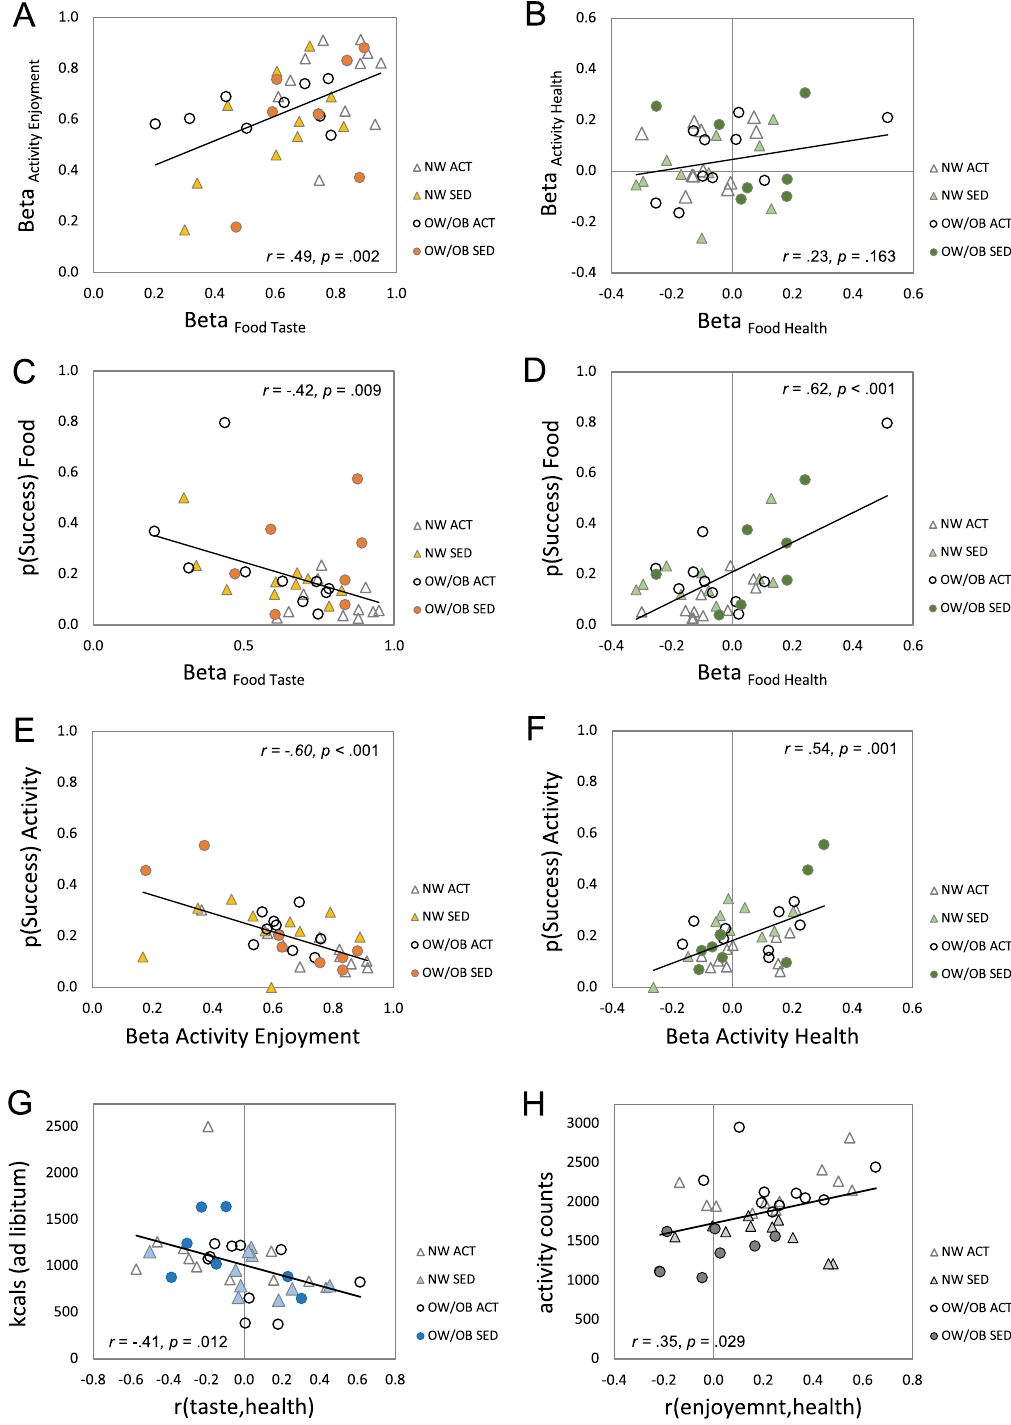
Figure 3. ( A ) The beta weights of food taste attribute were positively correlated with the beta weights of activity enjoyment attribute. ( B ) The beta weights of food health attribute were not significantly correlated with the beta weights of activity health attribute. ( C ) The beta weights of food taste attribute were negatively correlated with the proportions of successful self-control in food decisions. ( D ) The beta weights of food health attribute were positively correlated with the proportions of successful self-control in food decisions. ( E ) The beta weights of activity enjoyment attribute were negatively correlated with the proportions of successful self-control in activity decisions. ( F ) The beta weights of activity health attribute were positively correlated with the proportions of successful self-control in activity decisions. ( G ) The correlations between food taste and health attribute ratings were negatively associated with the amount of food consumption (kcals) at the ad libitum pizza buffet ( M = 1023, SD = 369). ( H ) The correlations between physical activity enjoyment and health attribute ratings were positively associated with the physical activity level monitor measures of the 2-week assessment period ( M = 1866, SD = 418). n =